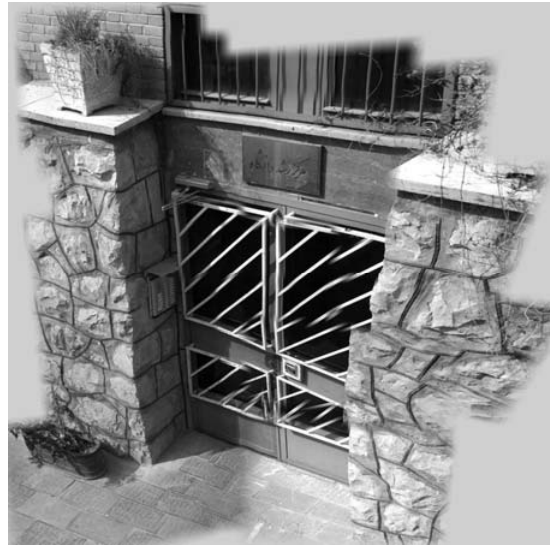
Figure 8. High-resolution and wide stitched image in sink.